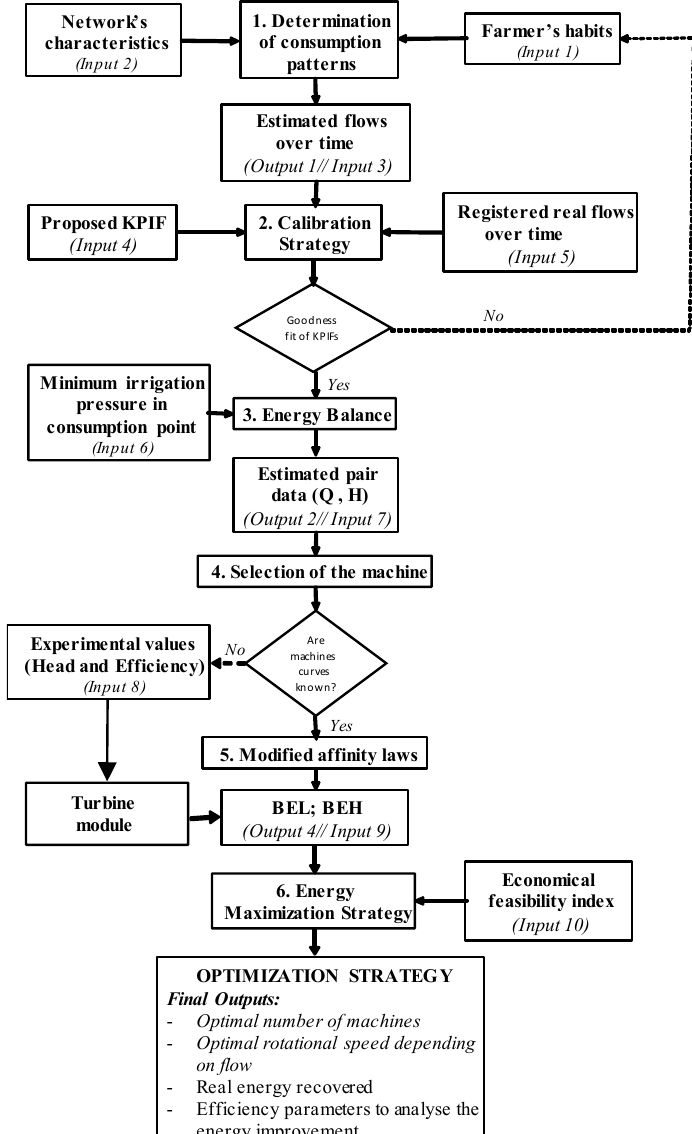
Figure 4. Scheme of the optimization strategy to improve the energy efficiency.